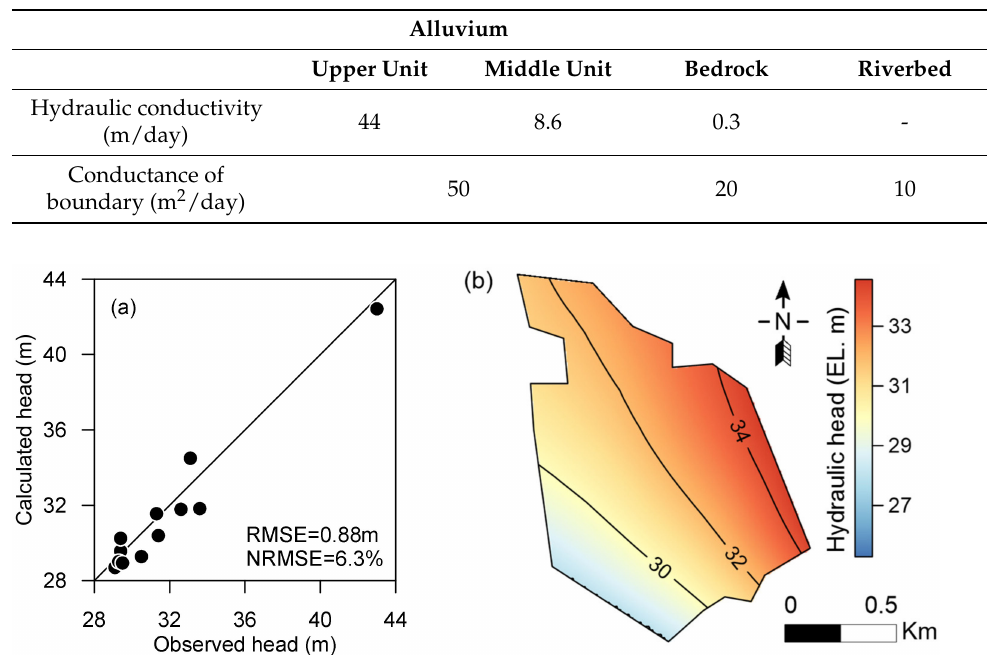
Figure 4. Calibration results: ( a ) comparisons between calculated and measured groundwater levels; ( b ) calculated groundwater level